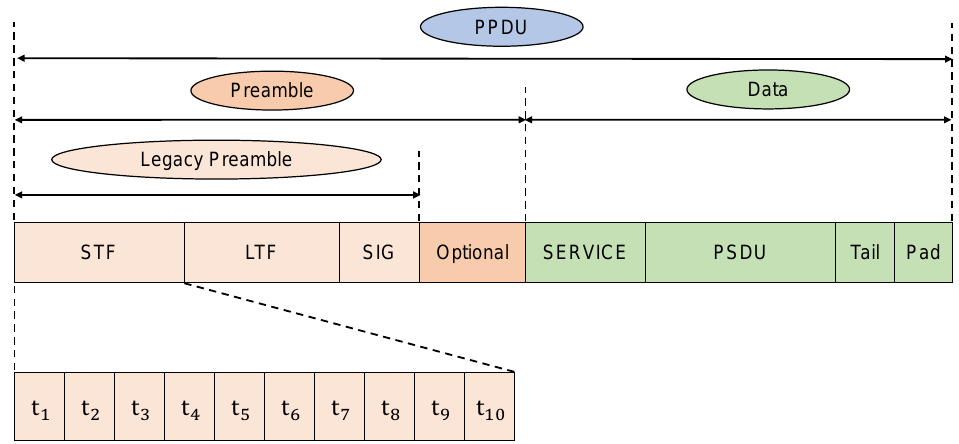
Figure 3. PPDU of OFDM signals. The STF consists of 10 identical short